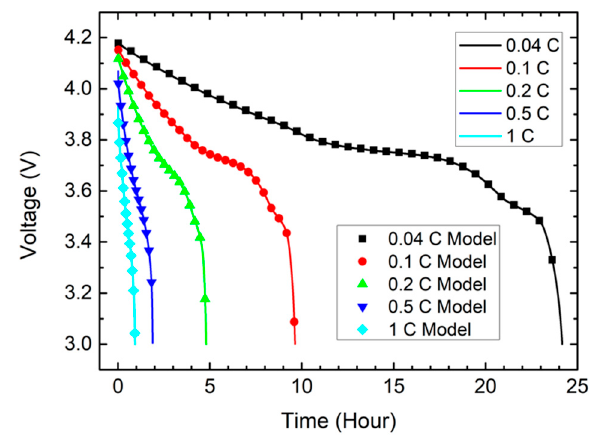
Figure 7. Curve of S brand 18650, Epoch = 100, look_back = 10.